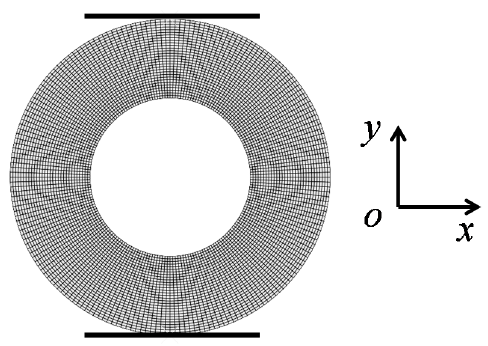
Figure 12. Finite element model of diametrical compression test.